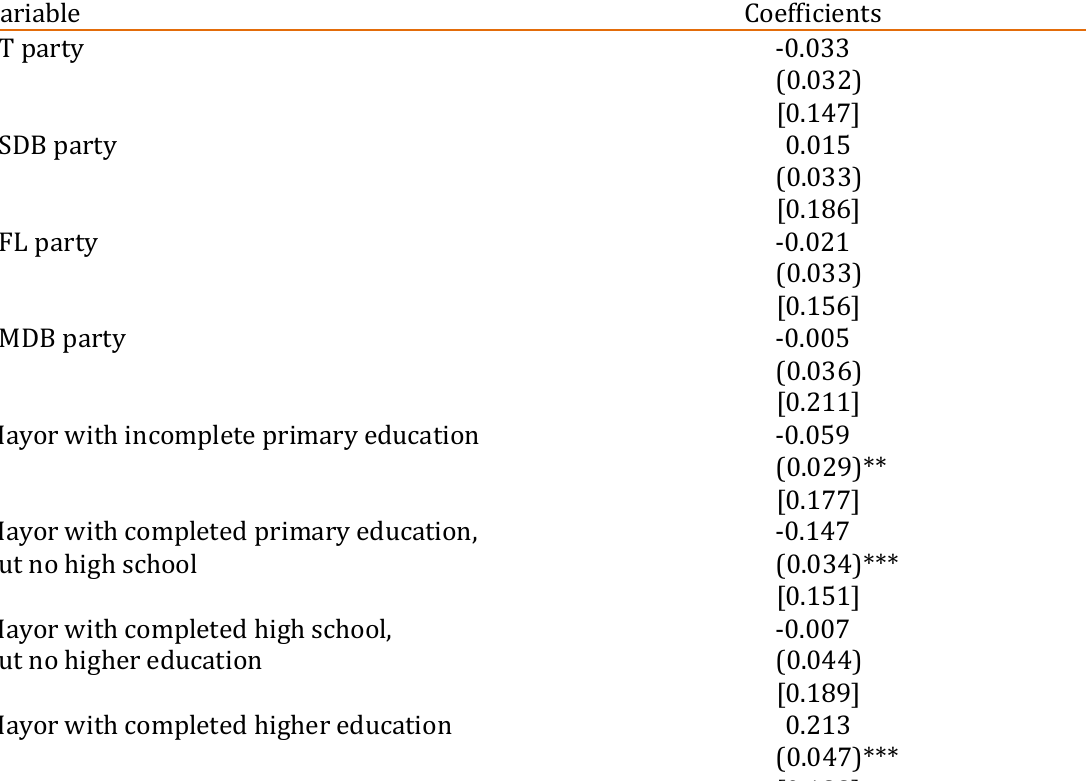
Table 02. Balance tests of characteristics between mayors in treated (female mayor) and control (male mayor) municipalities